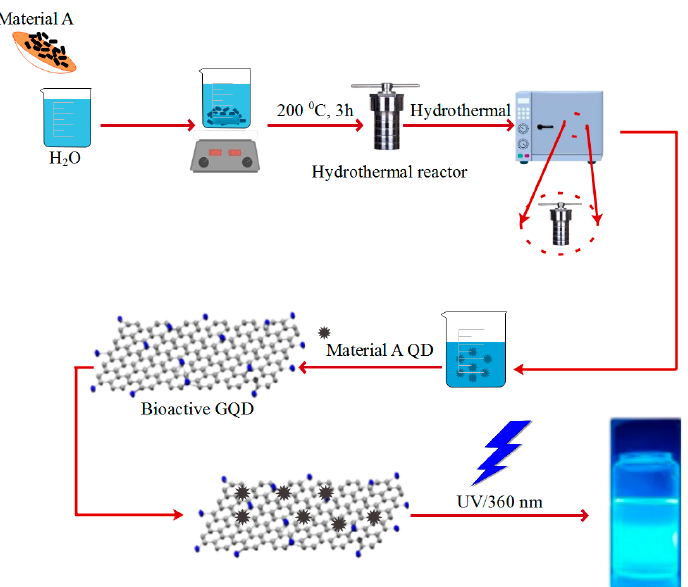
Figure 3. Synthesis of photoluminescence GQDs by using hydrothermal method from material